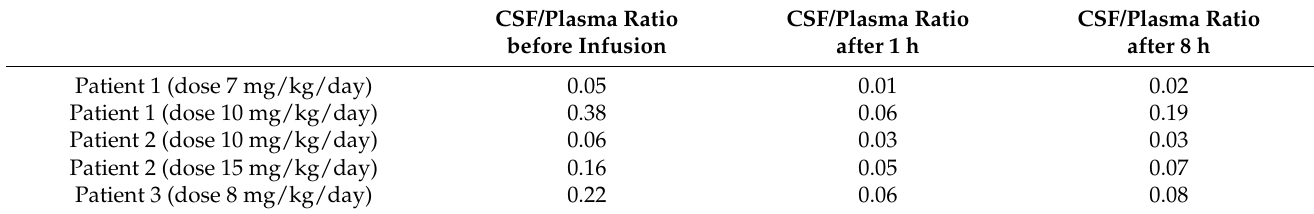
Table 5. CSF/plasma ratios in three patients before and after different dose infusions.